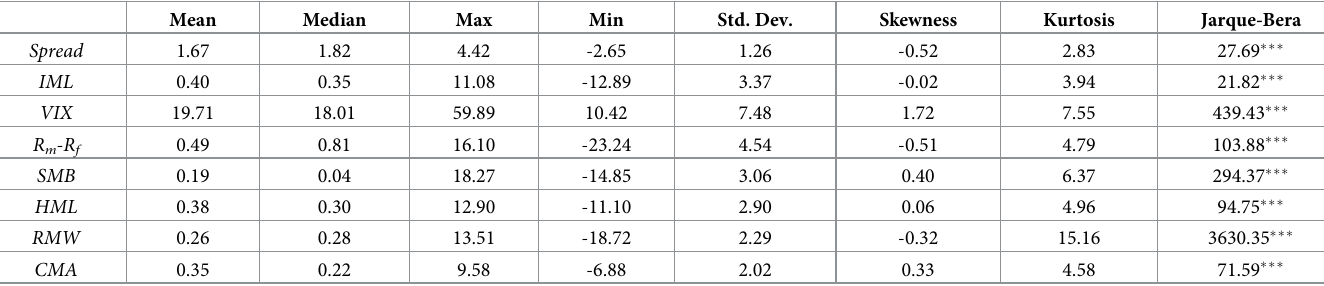
Table 2. Conditional Fama-French model risk factors 1968 m01-2016